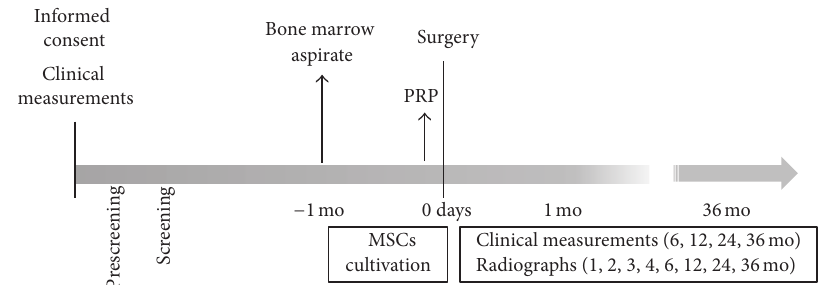
Figure 1: Treatment